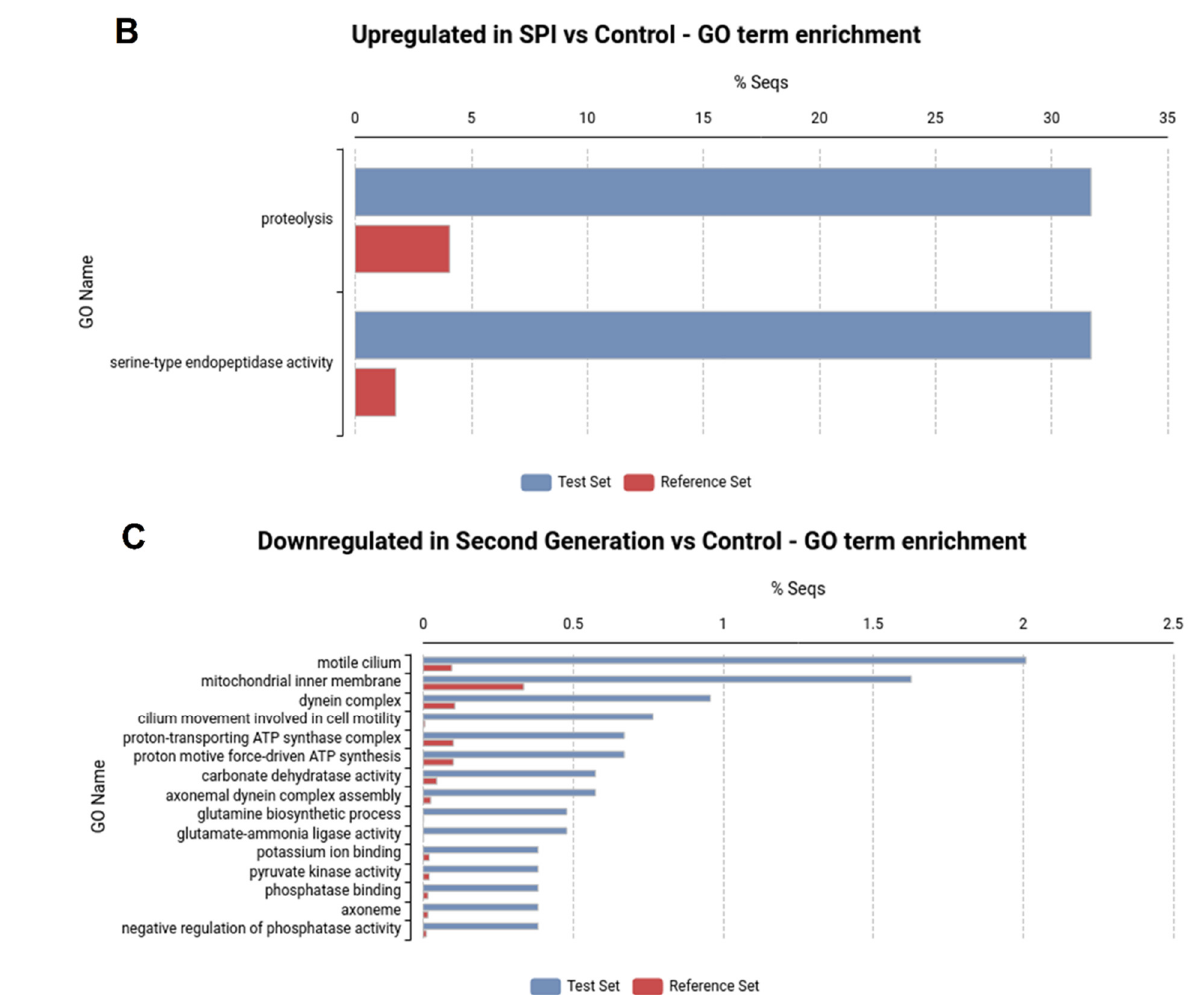
Figure 2. Enrichment analysis showing percentage of sequences associated with over-represented GO terms out of the genes that were ( A ) downregulated, ( B ) upregulated in the digestive system of H. armigera by the presence of SPIs in the artificial diet, and ( C ) downregulated in the digestive systems of H. armigera progeny that were exposed to SPIs in comparison to reference set (all genes expressed).